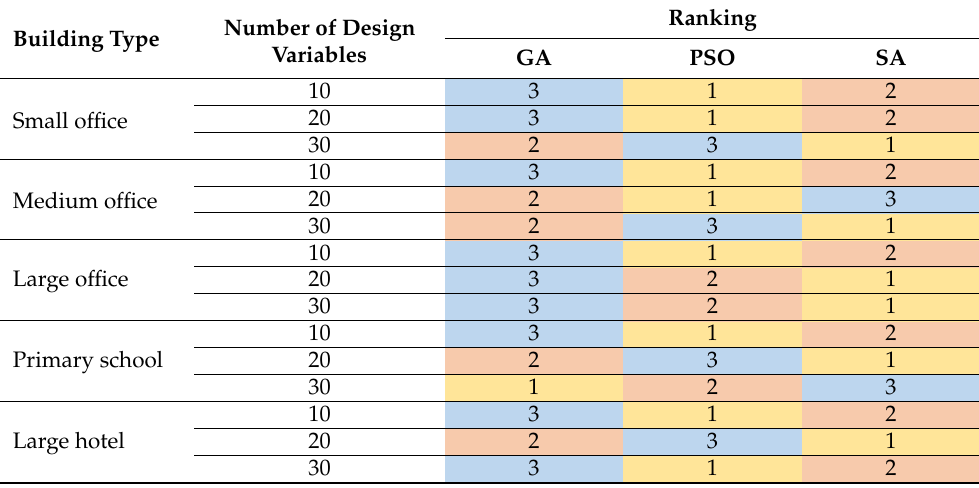
Table 11. Ranking results of the number of simulations required by the three single-objective test algorithms when using the optimal